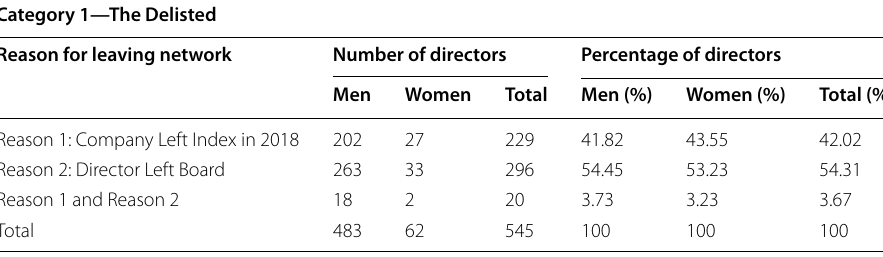
“Reason 1 and Reason 2” means that a director had multiple positions and she/he left the network because the company left the ASX200 index in 2018 and she/he also left the board of a company that was still in the 2018 ASX200 index